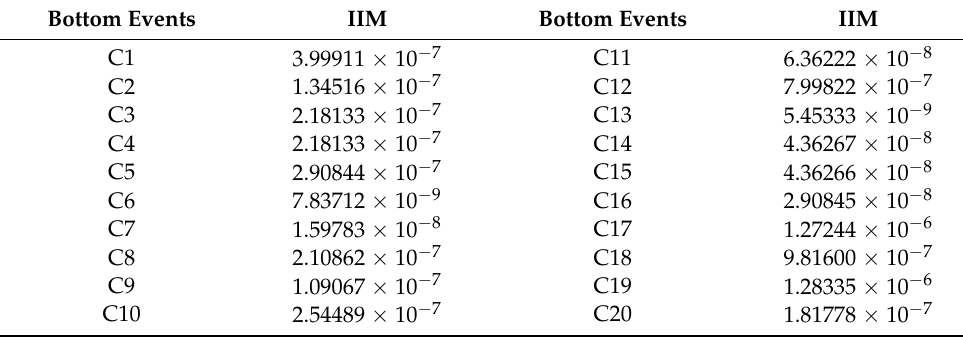
Table 5. Integrated importance measure values of the bottom